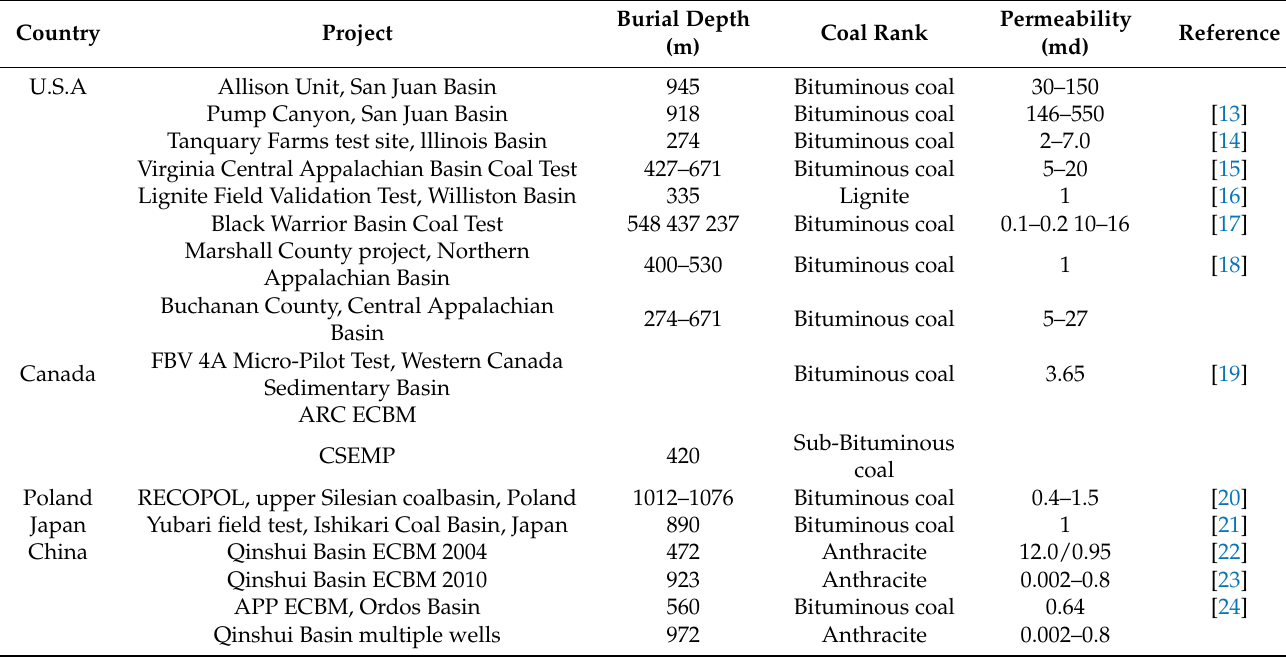
Table 1. Existing CO 2 -ECBM field